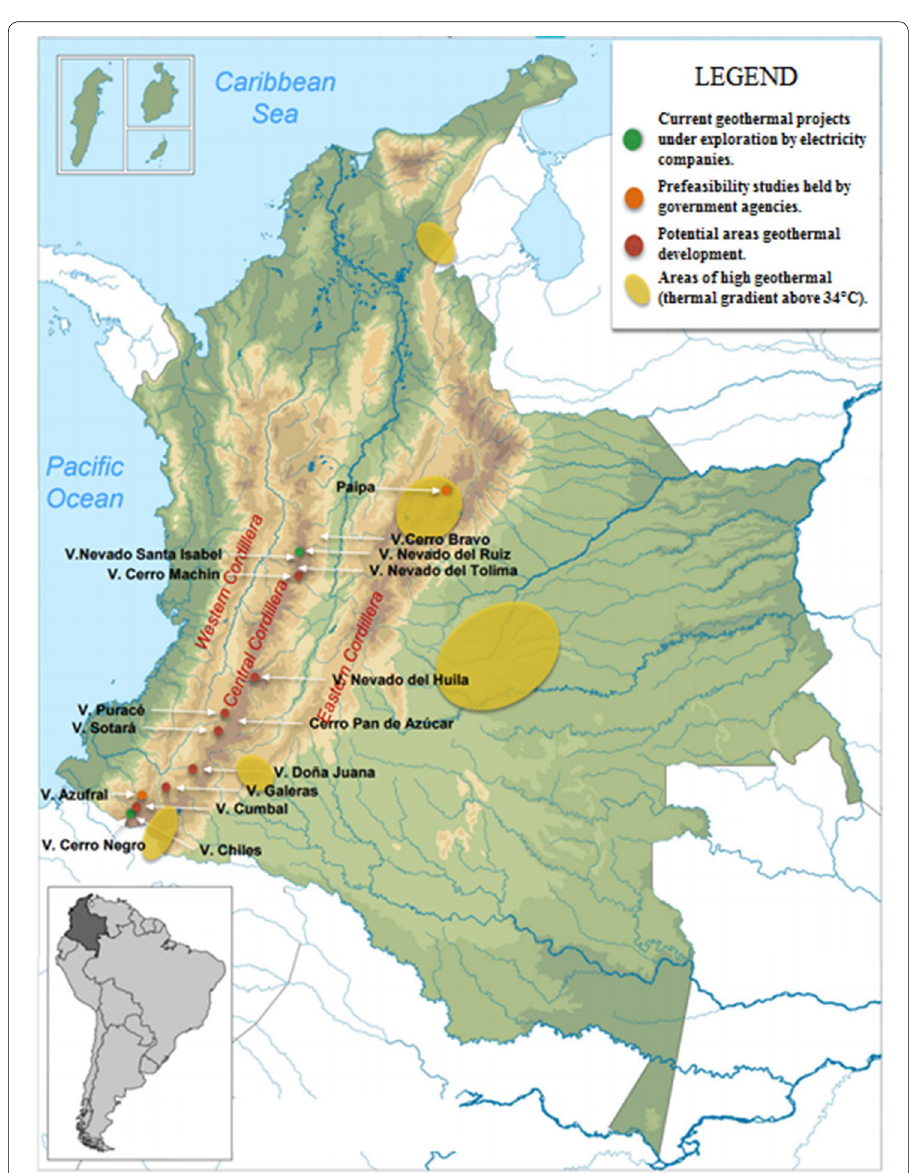
Fig. 5 Areas with geothermal potential in Colombia (Reproduced with permission from Mejía and Rayo